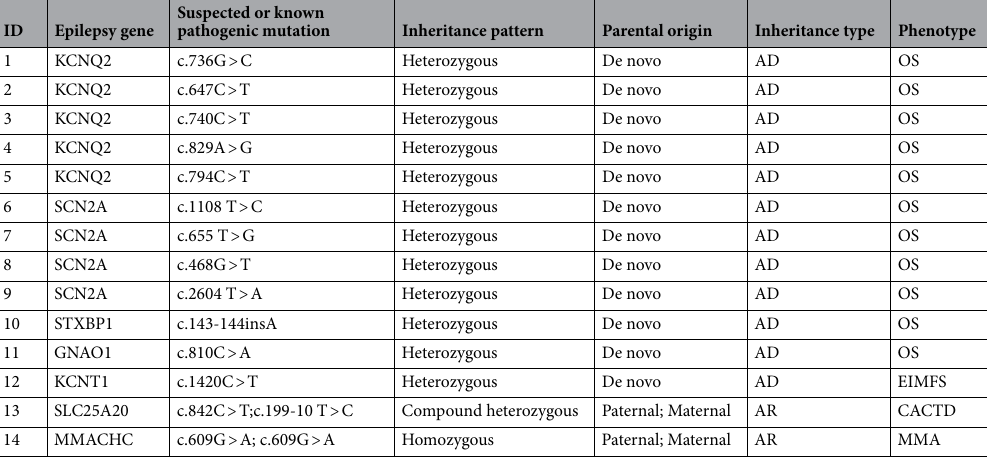
Table 2. The gene mutation types of patients. OS Ohtahara syndrome, EIMFS Epilepsy of infancy with migrating focal seizure, CACTD Carnitine-acylcarnitine translocase deficiency, MMA Methylmalonic academia, AD Autosomal dominant, AR Autosomal